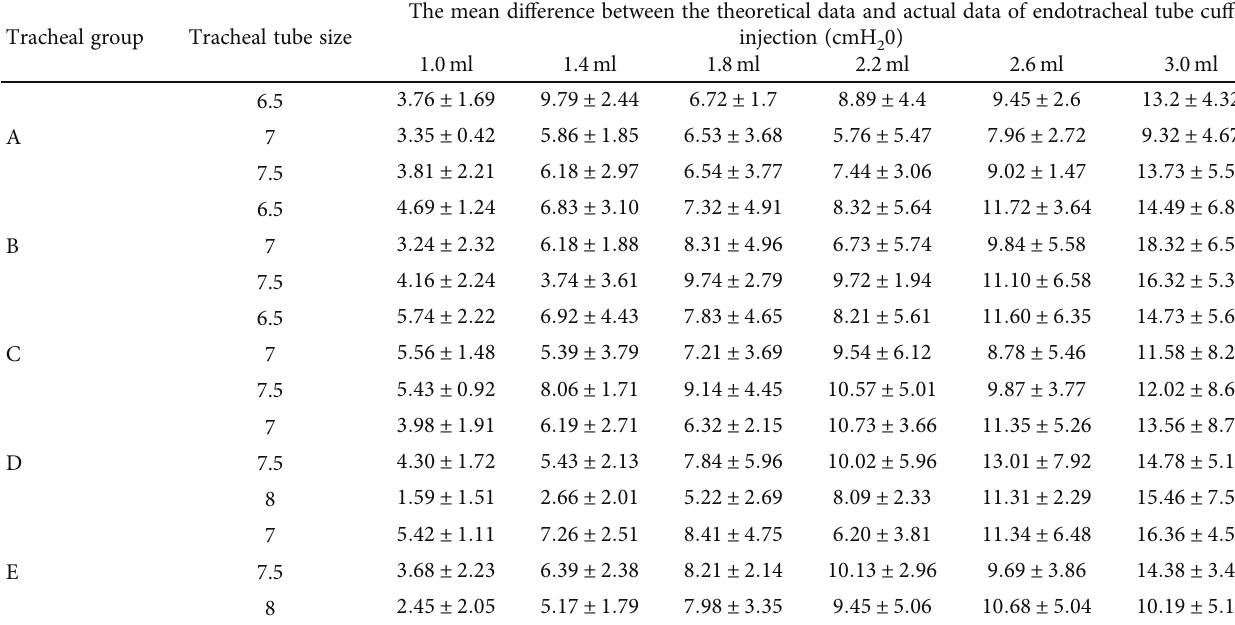
Table 2: The di ff erence between the actual cu ff pressure and theoretical cu ff pressure inferred by the formula. The mean di ff erence between the theoretical data and actual data of endotracheal tube cu Tracheal group Tracheal tube size